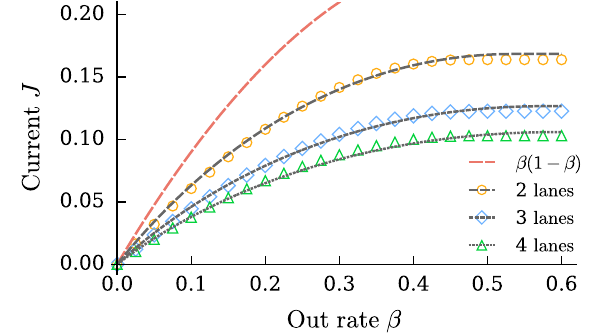
FIG. 15. Average system current as a function of the out rate β in the high-density phase for different numbers of lanes for the special case δ ¼ 1 = 2 . Comparison between stochastic simula- tions (symbols) and theoretical predictions (lines). The current increases monotonically with increasing out rate. For sufficiently high out rates, the system enters the maximal-current phase, and the current becomes constant. The assumption of ρ L ¼ 1 − β with a corresponding out flux of J ¼ β ð 1 − β Þ (uppermost dashed line) fails to describe our model.